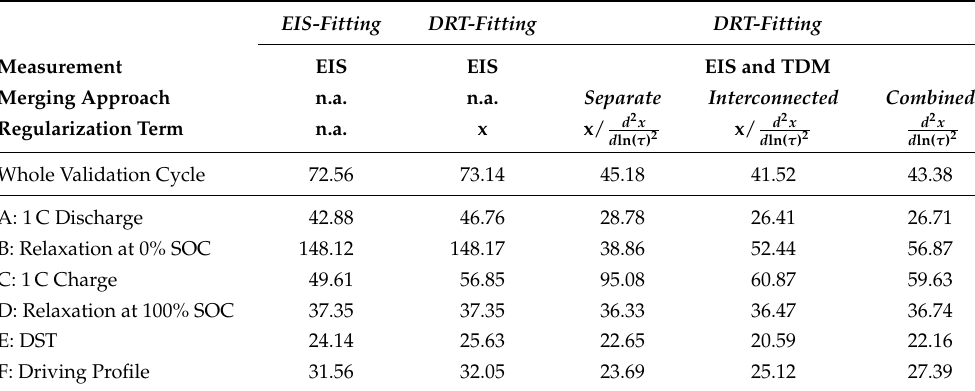
Table 2. Comparison of the RMSE in mV during the validation cycle of different RC parameter sets. EIS-Fitting DRT-Fitting